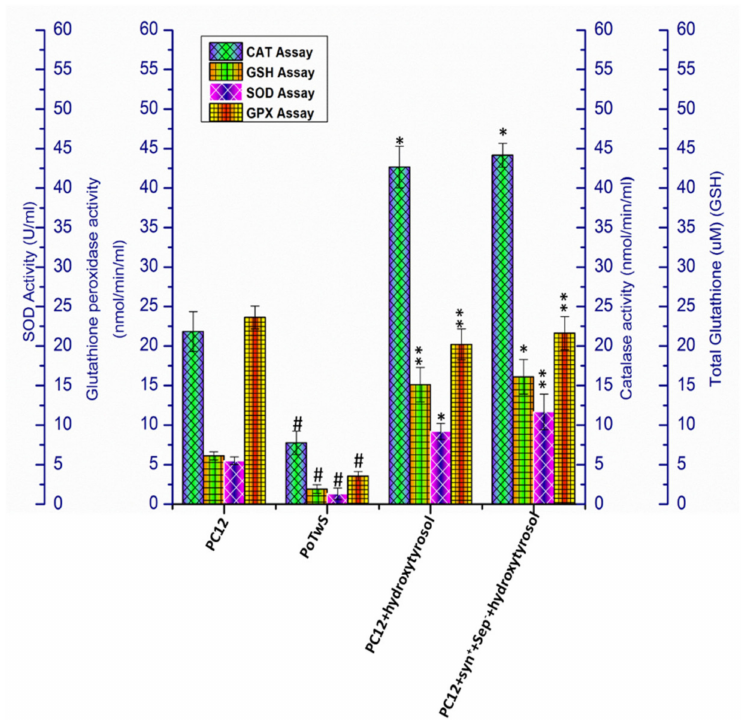
Figure 4. Analysis of activity of catalase (CAT), glutathione reductase (GSH), superoxide dismutase (SOD), and glutathione peroxidase (GPx). The activity of CAT, GSH, SOD, and GPx was decreased in PoTwS cells compared to PC12 cells. Meanwhile, the PC12 + syn + + sep − + hydroxytyrosol cells line displayed the highest CAT and GSH activity compared to PoTwS cells. The description of each cell line is given in Supplementary Table S3. Data are mean and S.E. values from three independent experiments ( n = 3). # p < 0.01, relative to PC12 (control cells). * p < 0.05 and ** p < 0.01, relative to the cells treated only with